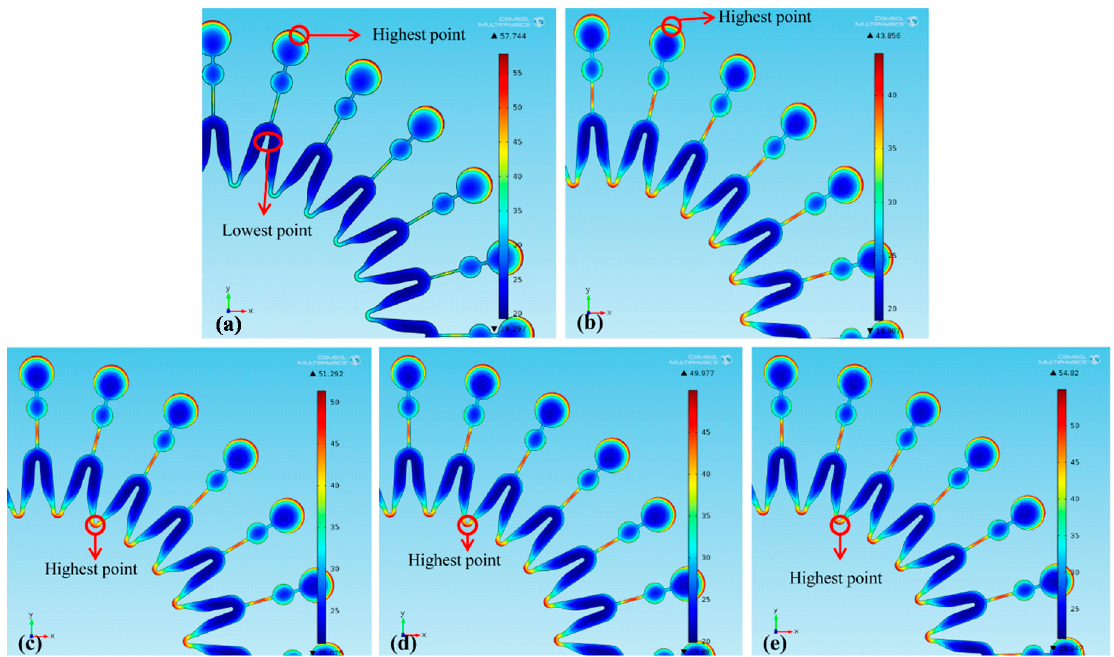
Figure 6. Thickness distribution of the electroforming mold: ( a ) without a second cathode; ( b ) W = 4 mm; ( c ) W = 5 mm; ( d ) W = 6 mm; ( e ) W = 7 mm. Table 5. Dependence of α on W .